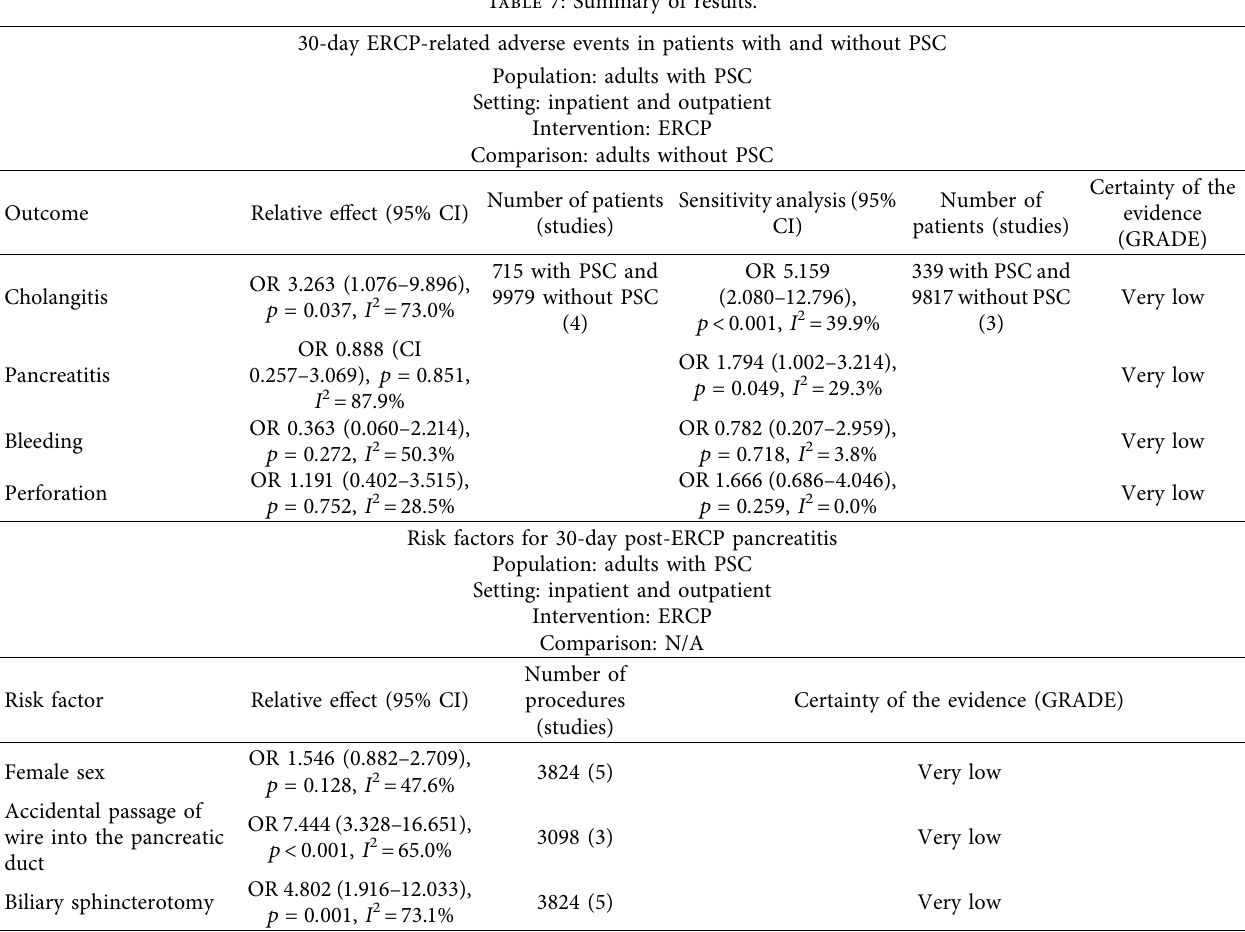
Table 7: Summary of